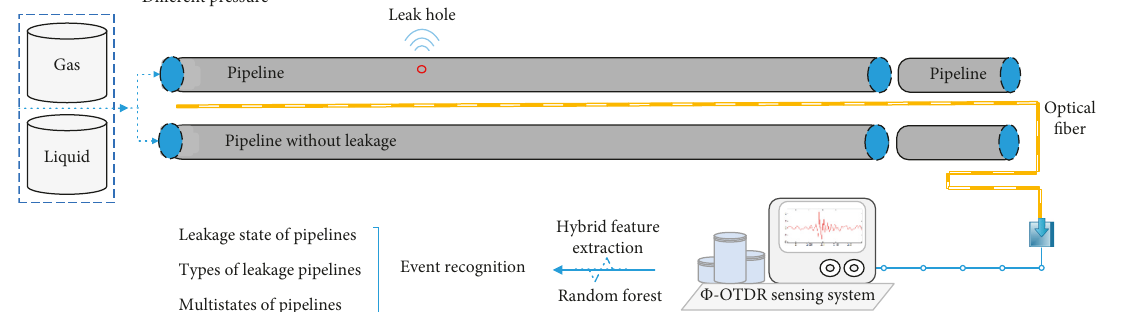
Figure 1: Schematic diagram of the pipeline leak experiment.